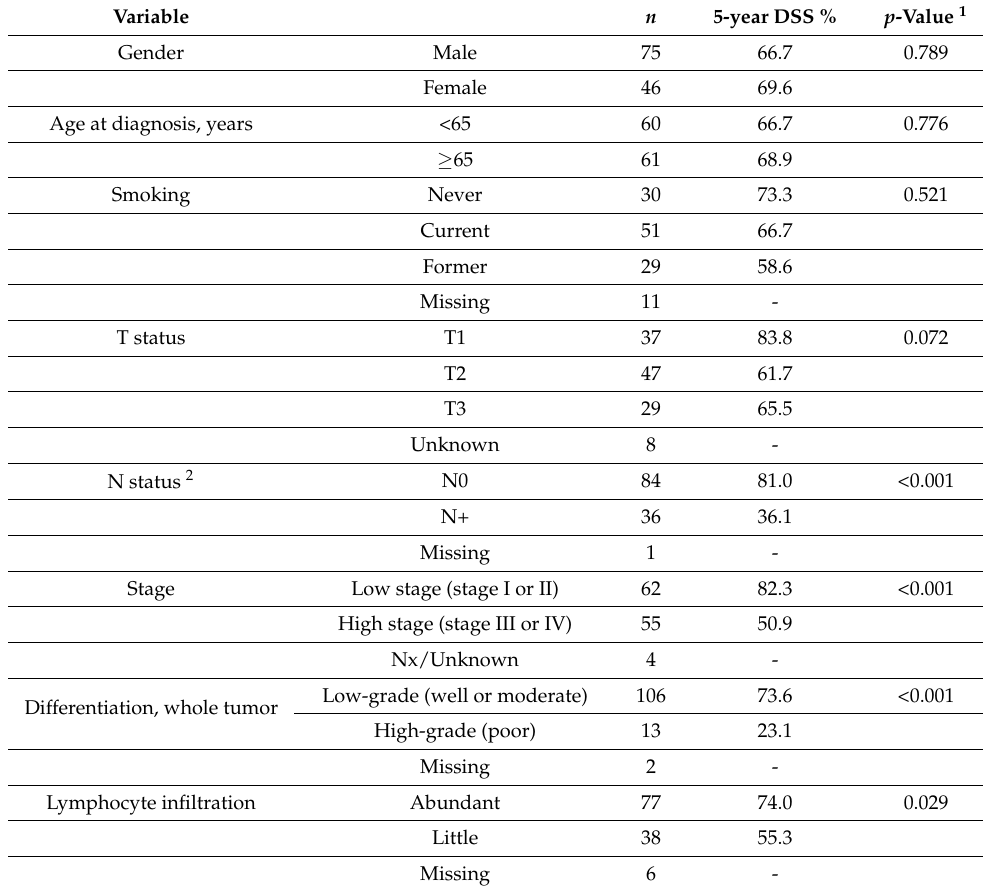
Table 2. Clinical–pathological characteristics of oral tongue squamous cell carcinoma patients with survival data ( n = 121), and their association with 5-year disease-specific survival (DSS) in Kaplan– Meier